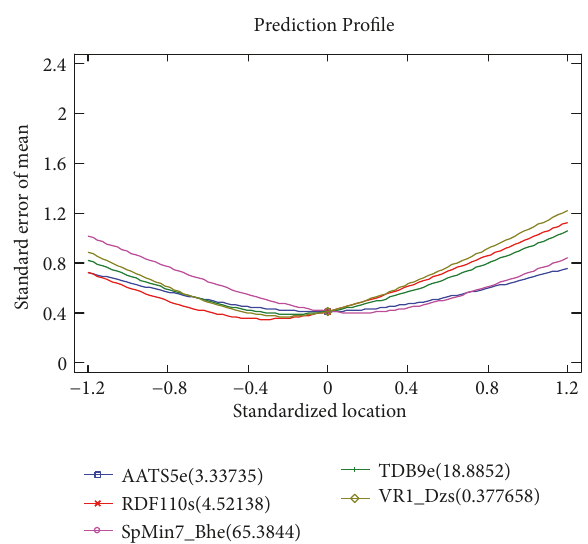
Figure 7: Prediction profile graph displays the standard error of the predicted